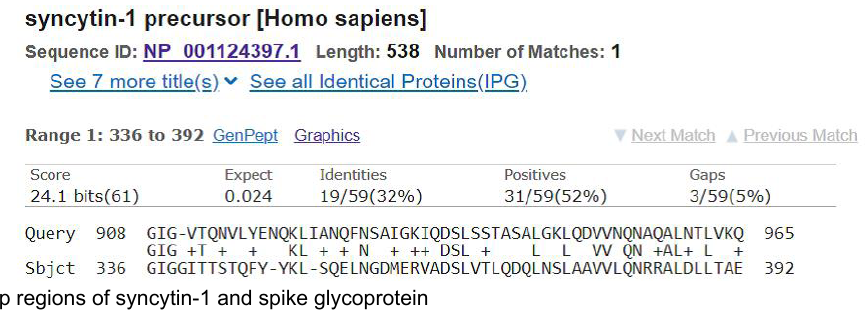
2) Due to similarity (Figure 2) between the spike glycoprotein and syncytin-1 (Figure 3); generated antibodies or other immune changes (likely T-cell-mediated) will confuse the two proteins (cross-react) and therefore attack syncytin-1 expressing cells.